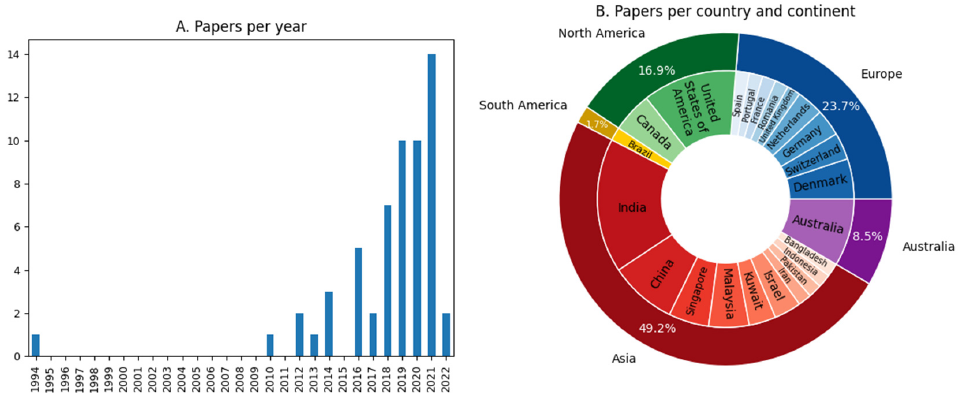
Figure 2. ( A ) Bar plot of number of selected articles per year taking into account their issue publication. ( B ) Pie-chart with the distribution of the selected articles according to the country and continent associated with the first affiliation of the first author.